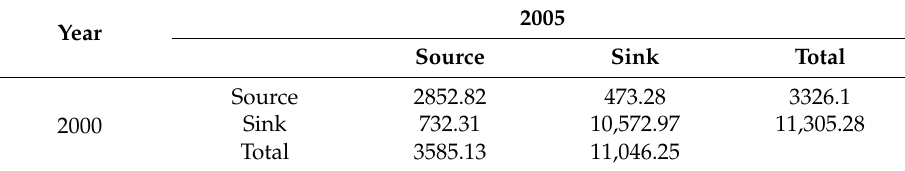
Table 26. The source-sink landscape transition matrix from 2000 to 2005 (km 2 ).